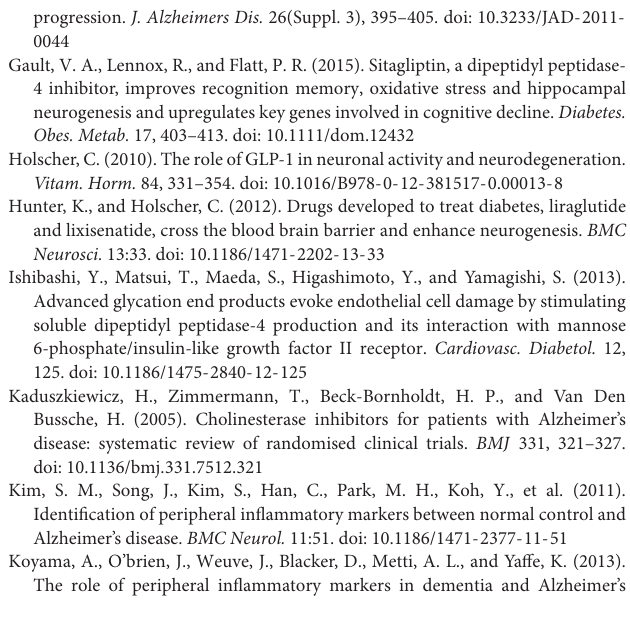
FIGURE S1 | Correlations between DPP4 activities vs metabolic parameters and MoCA score represented by scatter plot. (A) relationship between DPP4 activity and IL-6; (B) relationship between DPP4 activity and CRP; (C) relationship between DPP4 activity and nitrotyrosine; (D) relationship between DPP4 activity and 8-iso-PGF2a; (E) relationship between DPP4 activity and fasting active GLP-1; (F) relationship between DPP4 activity and MoCA